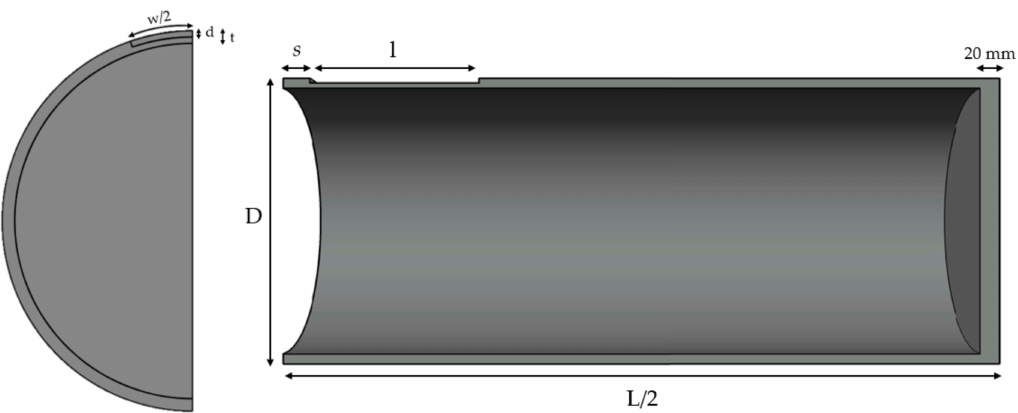
Figure 1. Dimensions of the quarter pipe model.